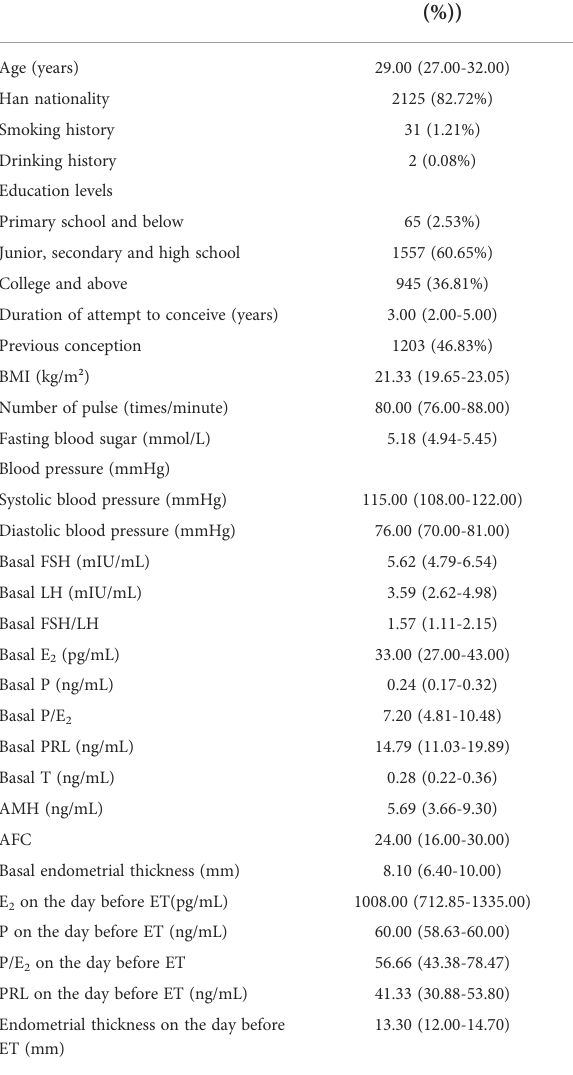
TABLE 1 Parameter of the study